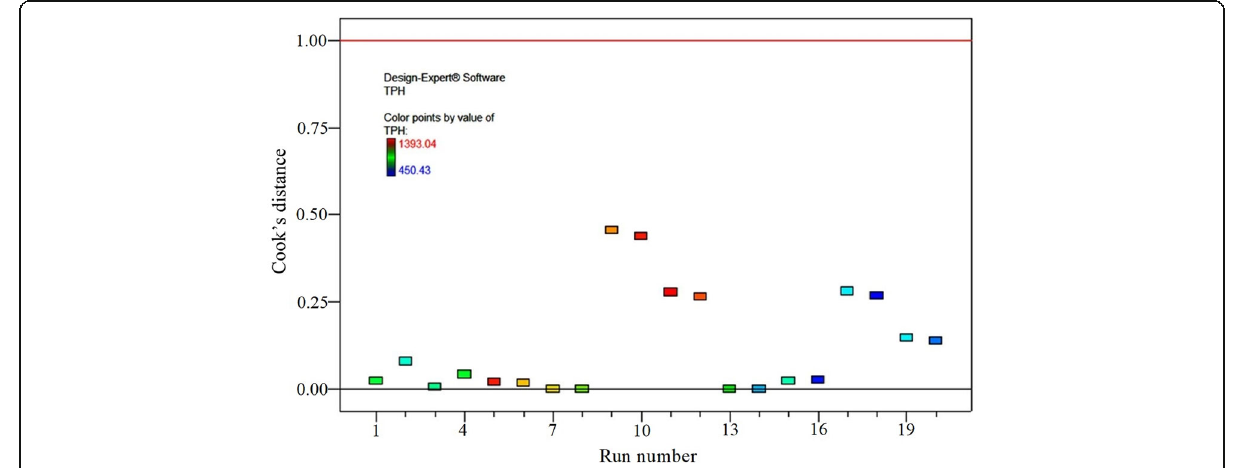
Fig. 6 Generated cook ’ s distance for TPH